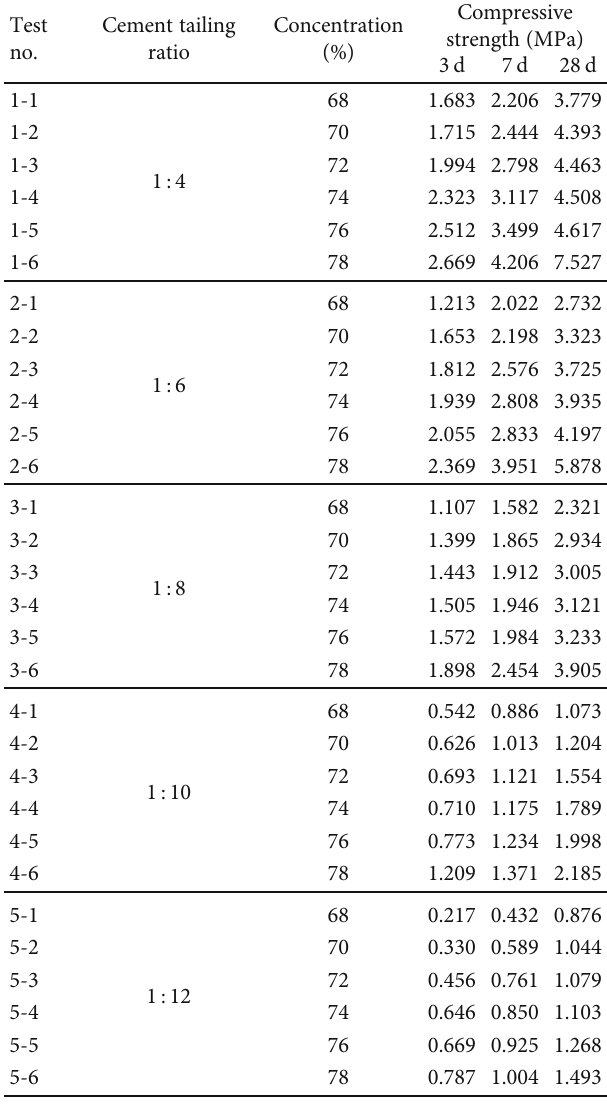
Table 7: Uniaxial compressive strength test data of total tailing high-concentration fi lling